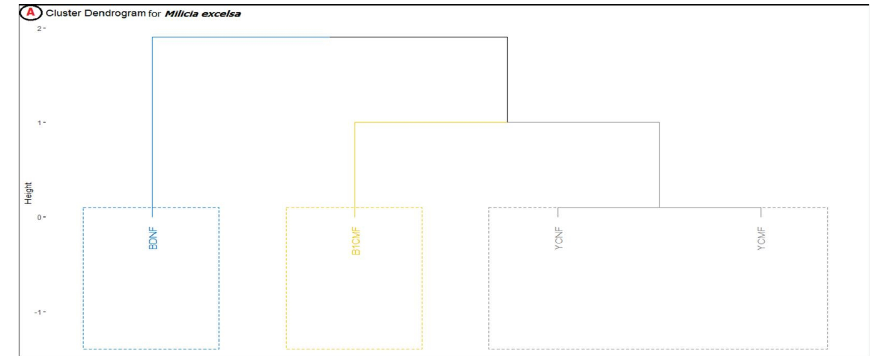
Figure 3: Hierarchical clustering of the populations of M. excelsa based on one scaled morphometric data using “Euclidean” distance and “Wards.D2” method. YCMF � Yayu cofee mixed forest, B1CMF � Bebeka 1-cofee mixed forest, BDNF � Bebeka-Duduka natural forest, YCNF � Yayu-Chach natural